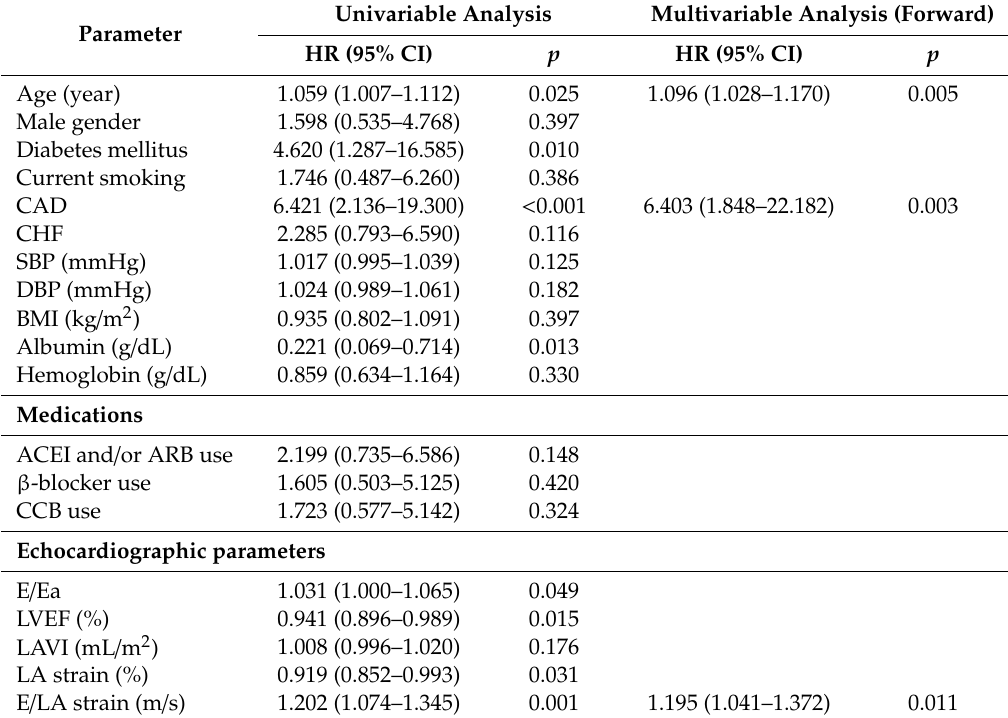
Table 5. Predictors of cardiovascular mortality using the Cox proportional hazards